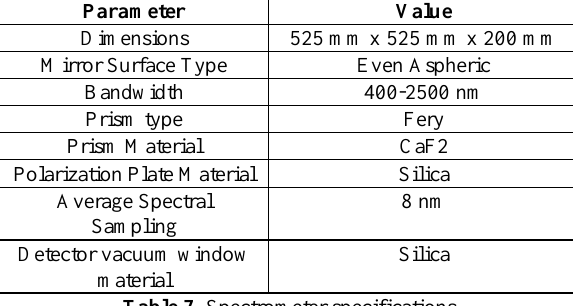
Figure 9. Overall HSI optical design layout